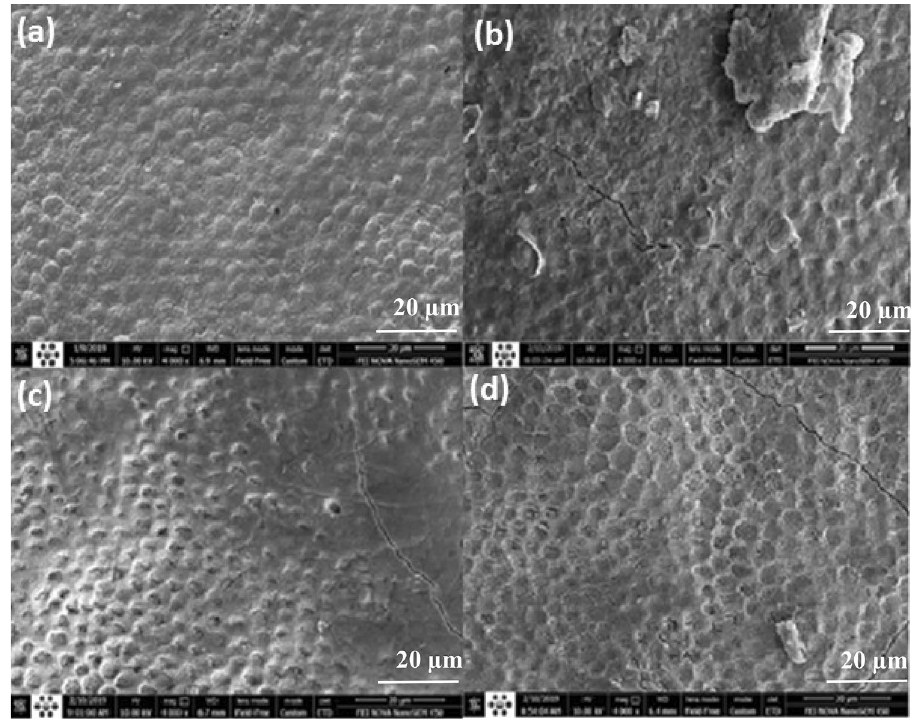
Figure 2. SEM images related to enamel surface treatment with (a) control group, process-free specimen, (b) Air-DBD, (c) ArJ, (d)